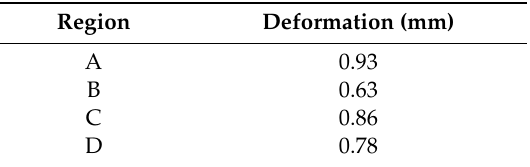
Figure 7. The bare land regions which were used to verify the glacier deformation results. Table 4. Deformations of the bare land regions shown in Figure 7 between 18 November 2017 and 31 December 2018.